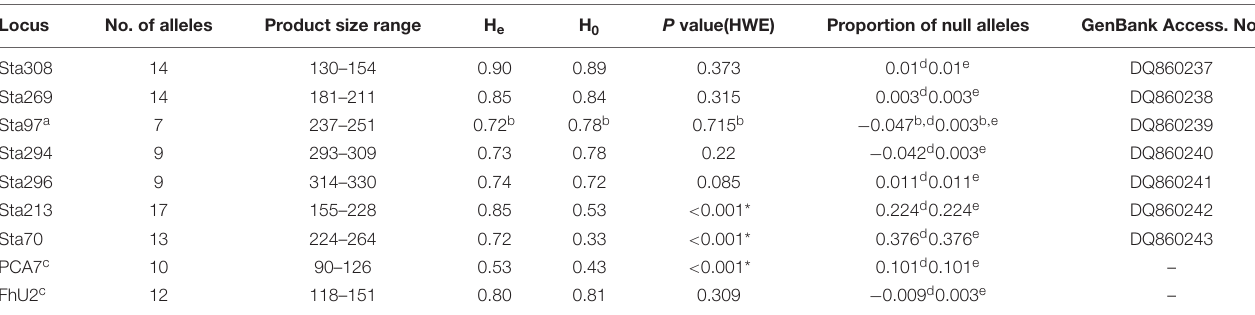
TABLE 1 | Characteristics of nine microsatellite loci amplified for 184 adult spotless starlings. Locus No. of